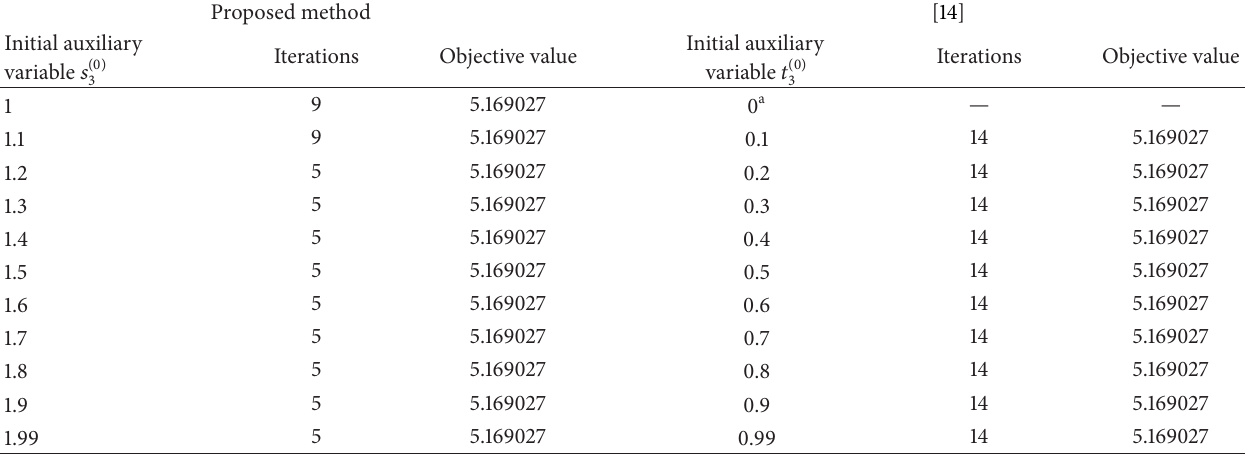
Table 2: Comparisons between our proposed algorithm and the method in [14] for Case study 1.